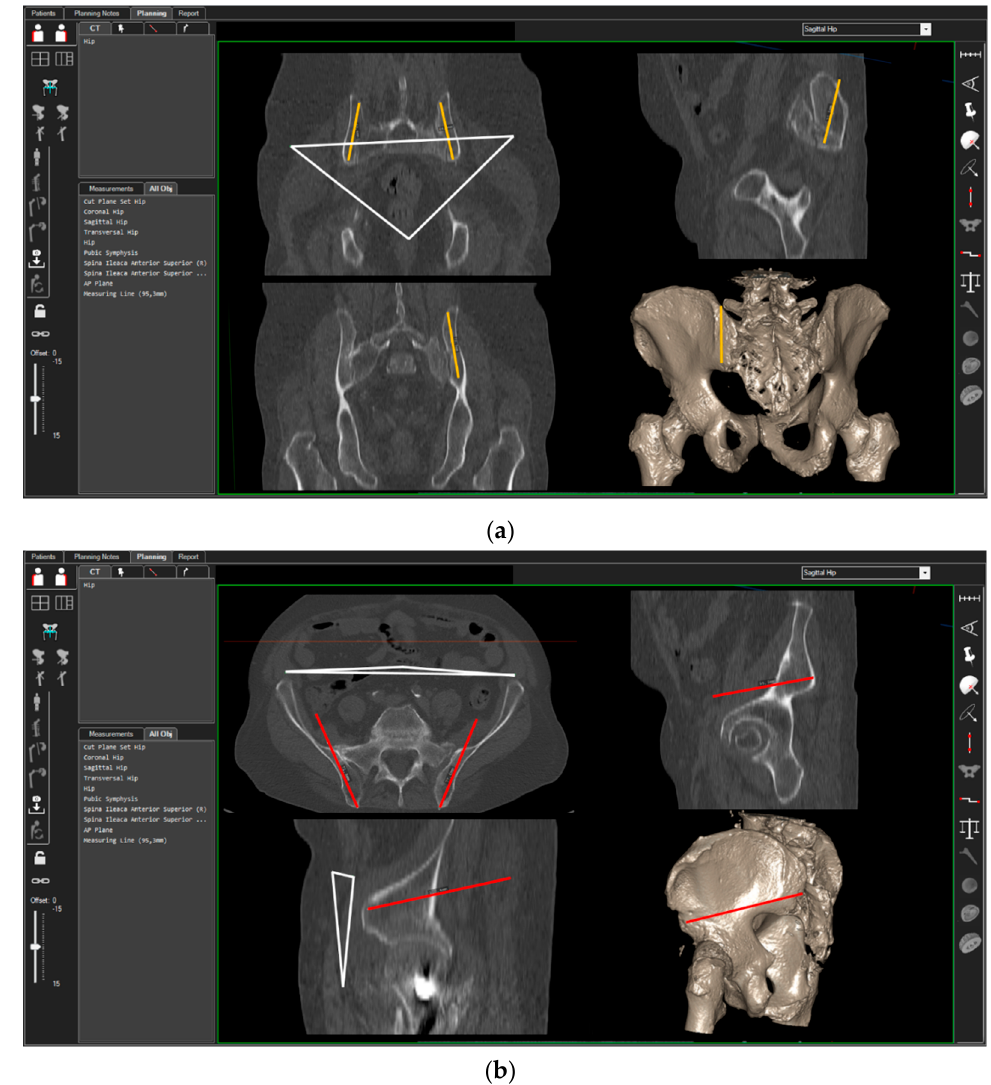
Figure 2. Setting of the 3D-CT-based measurement of the ilium screws in cranio-caudal ( a ) and dorso-ventral ( b ) orientation. White triangle = anterior pelvic plane (APP); orange line = position of the TIFIcc, red line = position of the TIFIdv